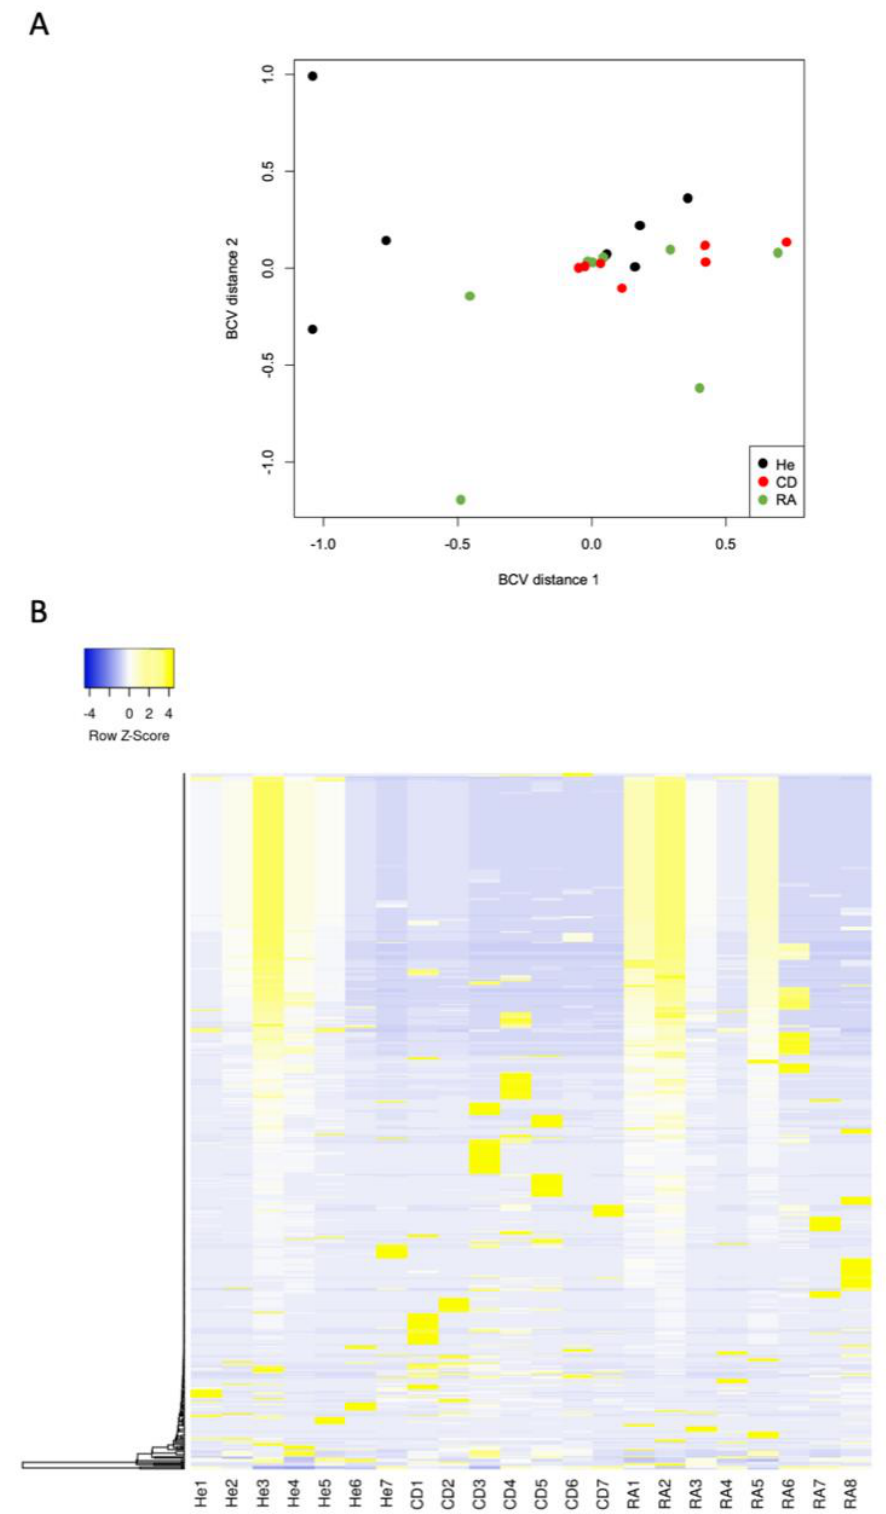
Figure 1. Principal components analysis of the most variable serum miRNAs in Crohn’s disease patients ( n = 7-red), rheumatoid arthritis patients ( n = 8-green) and control health patients ( n = 7-black) ( A ). Unsupervised hierarchical clustering of expression levels of the top miRNAs in serum of Crohn’s disease patients (CD, n = 7), rheumatoid arthritis patients (RA, n = 8) and control healthy patients (He, n = 7) ( B ).